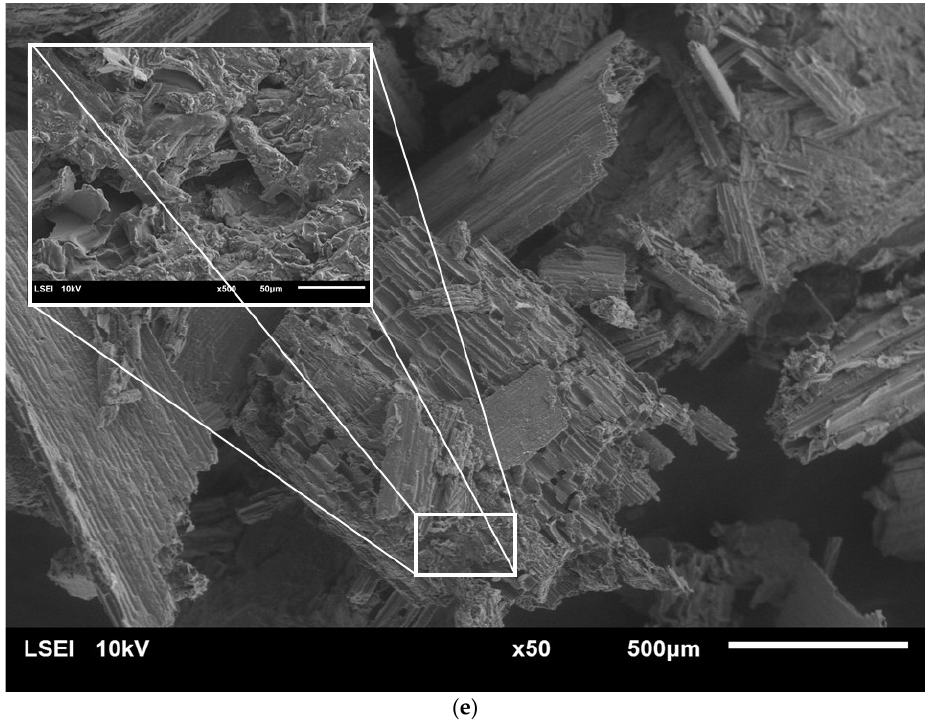
Figure 2. SEM images of raw rye straw under 50 and 200 or 500 magnification ( a ), rye straw after pretreatment with water at 121 °C and 1 h ( b ), rye straw after pretreatment with 5% sulfuric acid at 121 °C and 2 h ( c ) and 10% sulfuric acid at 121 °C and 1 h ( d ) and 10% sulfuric acid at 121 °C and 2 h ( e ).